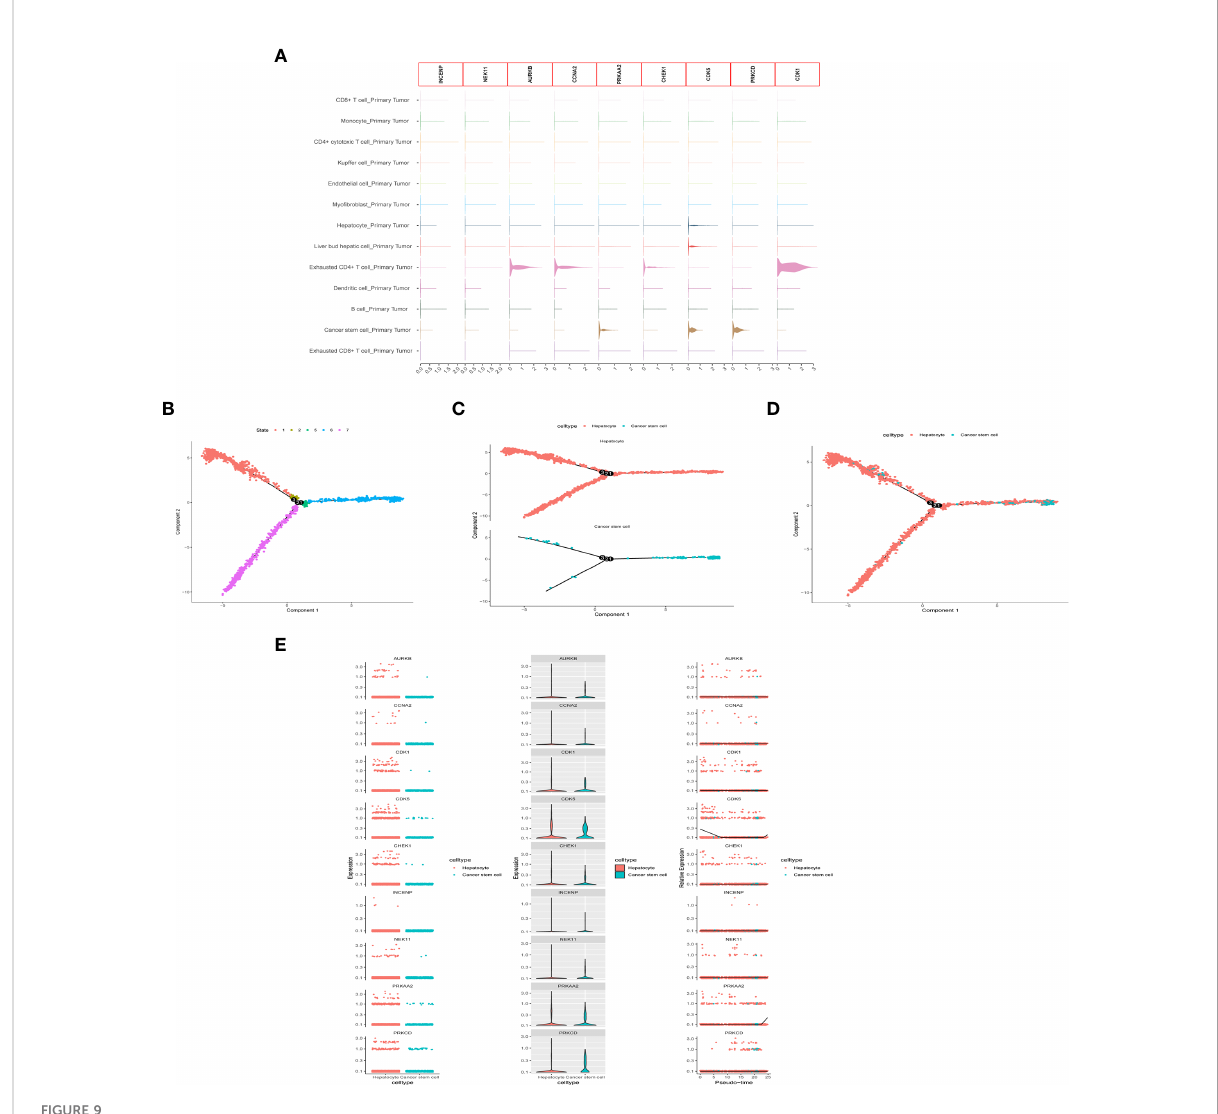
FIGURE 9 scRNA-seq Data processing and analysis. (A) Expression of the 9 genes in tumor tissue. (B-D) Pseudotime and cell trajectory analysis. (E) Changes of the 9 genes in cell trajectory